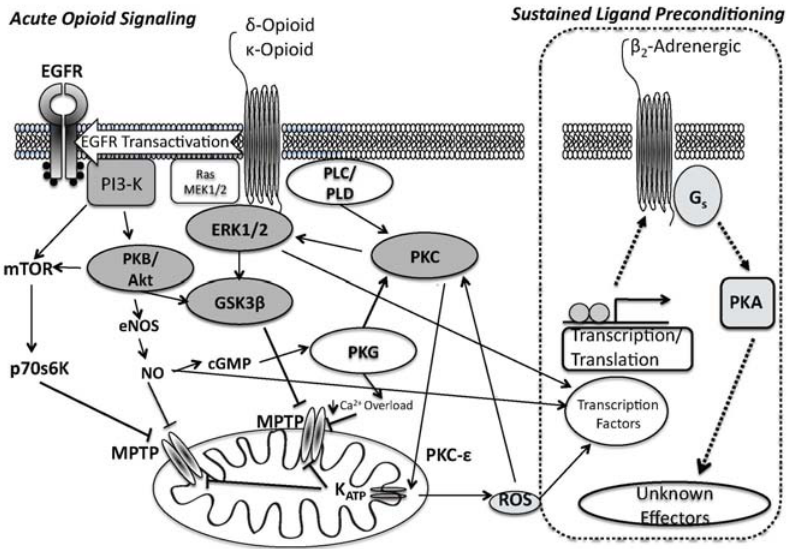
Figure 1. Generalized signaling scheme for acute- and sustained ligand opioid-dependent cardioprotection. Sustained ligand preconditioning with opioids appears to share common ‘acute’ signaling during the induction phase of the phenotype. Shaded text identifies proteins shown to be involved in opioid-mediated cardioprotection. Dashed arrows imply unknown pathways/mechanisms of activation in sustained ligand activated